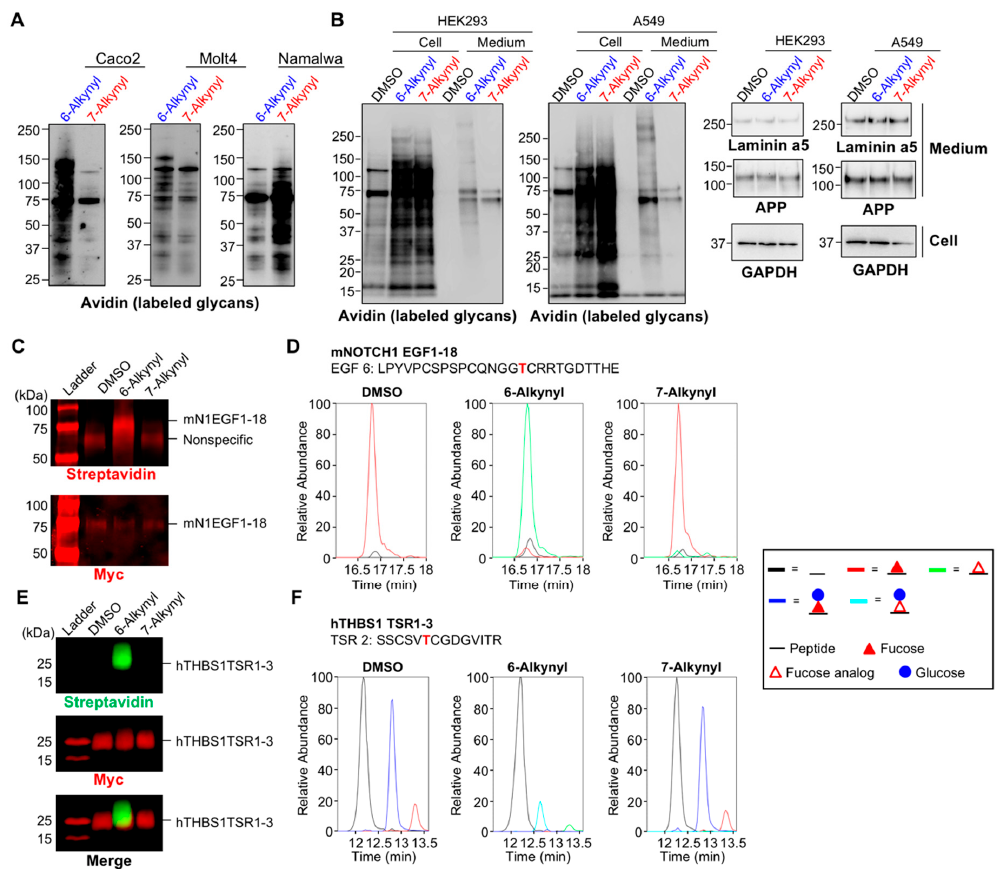
Figure 2. Differential glycoprotein labeling with 6-Alk-Fuc and 7-Alk-Fuc. ( A ) Caco-2, Molt4, and Namalwa cells were treated with peracetylated 6-Alk-Fuc, 7-Alk-Fuc, or DMSO. Incorporated Fuc analogs in the cell lysates were biotinylated by click chemistry, and the labeled glycans on proteins were detected by blotting with HRP-streptavidin. ( B ) HEK293 and A549 cells were treated with peracetylated 6-Alk-Fuc, 7-Alk-Fuc, or DMSO. Left 2 panels: Incorporated Fuc analogs in the cell lysates or secreted proteins were biotinylated by click chemistry, and the labeled glycans on proteins were detected by blotting with HRP-streptavidin. Right 2 columns: Proteins in the cell lysates and secreted into the culture media were western blotted with anti-laminin alpha 5, anti-APP, or anti-GAPDH. ( C ) HEK293T cells were transfected with mouse NOTCH 1 (mN1) EGF1-18 plasmid and incubated with 50 µ M peracetylated 6-Alk-Fuc or 7-Alk-Fuc for 4 days. mNOTCH1 EGF1-18 was purified from media and subjected to CuAAC with azido-biotin probe to examine Fuc analog incorporation. The samples were analyzed by Western blot. Top panel: Probed with streptavidin; bottom panel, probed with anti-Myc. ( D ) mN1 EGF1-18 was prepared as in C, digested with V8 protease, and the resulting peptides analyzed by mass spectrometry. An extracted ion chromatogram (EIC) of glycoforms of a peptide from mNOTCH1 EGF6 was prepared. Spectra for these ions are in Supplementary Figure S1. Black line, unmodified; red line, Fuc modified; green line, 6-Alk-Fuc or 7-Alk-Fuc modified. ( E ) HEK293T cells were transfected with hTHBS1 TSR1-3 plasmid and incubated with 50 µ M peracetylated 6-Alk-Fuc or 7-Alk-Fuc for 3 days. hTHBS1 TSR1-3 was purified from secreted media and subjected to CuAAC with azido-biotin probe to examine Fuc analog incorporation. The samples were analyzed by Western blot. Top panel: Probed with streptavidin; middle panel, probed with anti-Myc; bottom panel, merged. ( F ) hTHBS1 TSR1-3 was prepared as in E, digested with trypsin and chymotrypsin, and the resulting peptides analyzed by mass spectrometry. An EIC of the di ff erent glycoforms of a peptide from hTHBS1 TSR2 was prepared. Spectra for these ions are in Supplementary Figure S2. Black line, unmodified; red line, Fuc modified; blue line, glucose (Glc)-Fuc modified; green line, 6-Alk-Fuc or 7-Alk-Fuc modified; aqua line, Glc-6-Alk-Fuc or